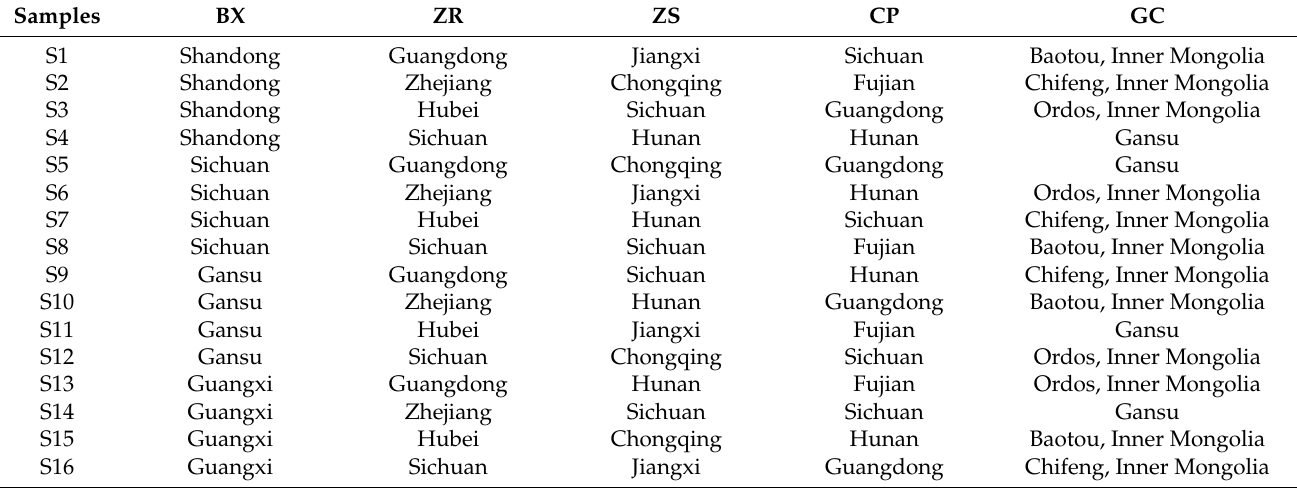
Table 6. Details of 16 batches of